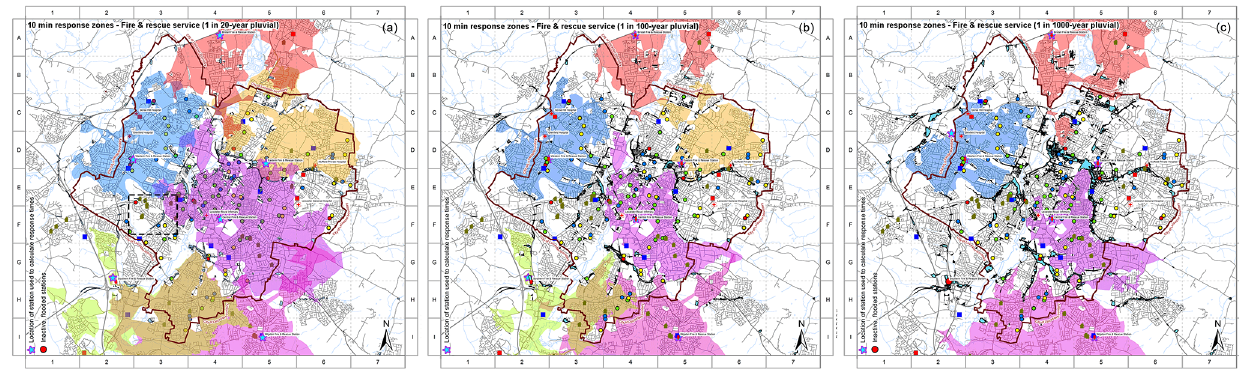
Figure 8. City-scale accessibility (within a 10min time frame) for fire and rescue service stations: (a) 1 in 20-year, (b) 1 in 100-year and (c) 1 in 1000-year surface water flooding scenarios. New Parks Lane, referred to in the text, is highlighted in the rectangle in Fig. 8a. See Fig. 6 for key.